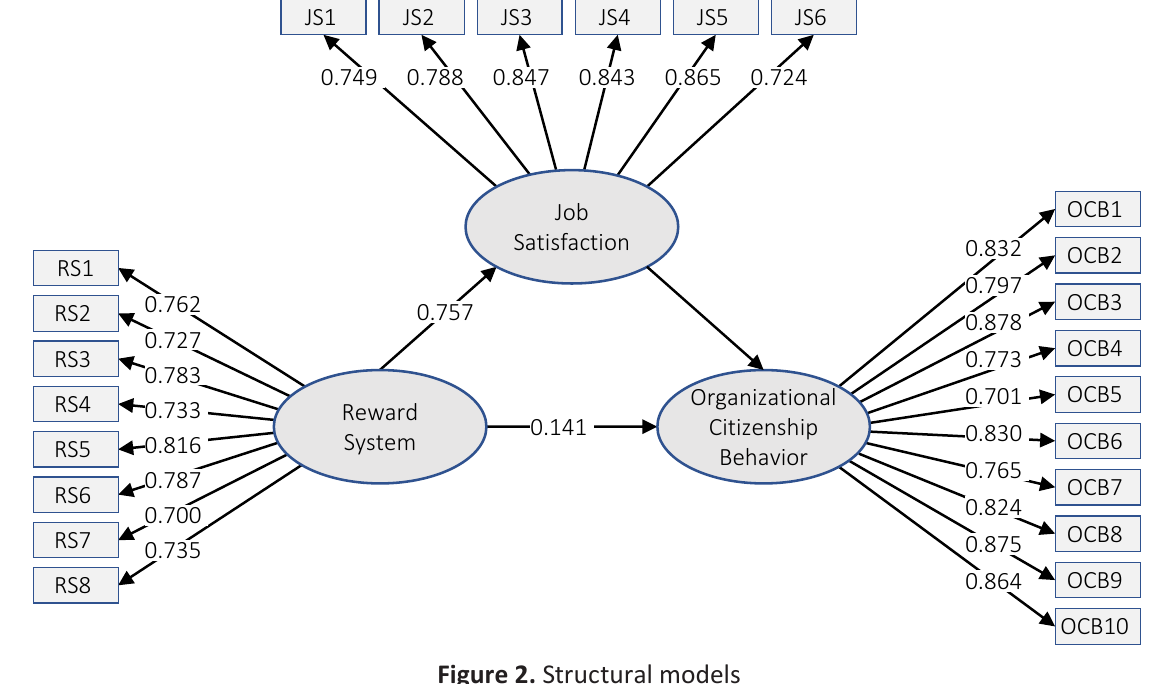
Figure 2. Structural